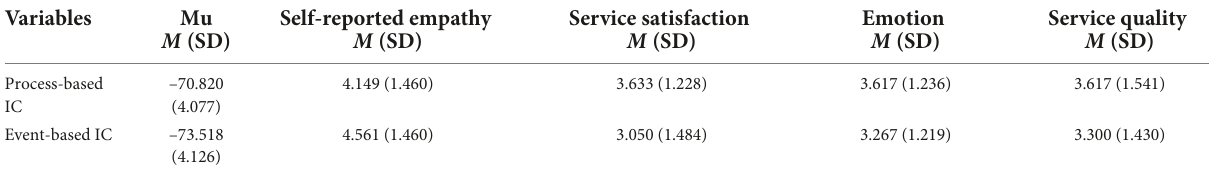
TABLE 1 Descriptive statistics of main variables by physician–patient communication style.